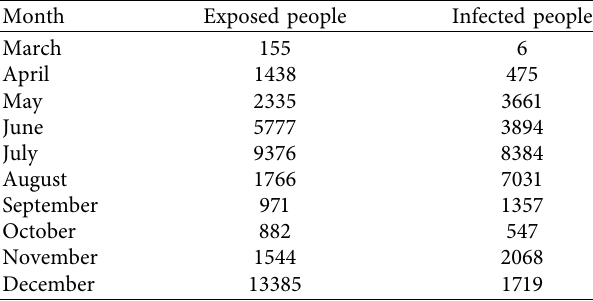
Table 5: Varied coefcients of difusion for the proportion of susceptible, exposed, and infective.